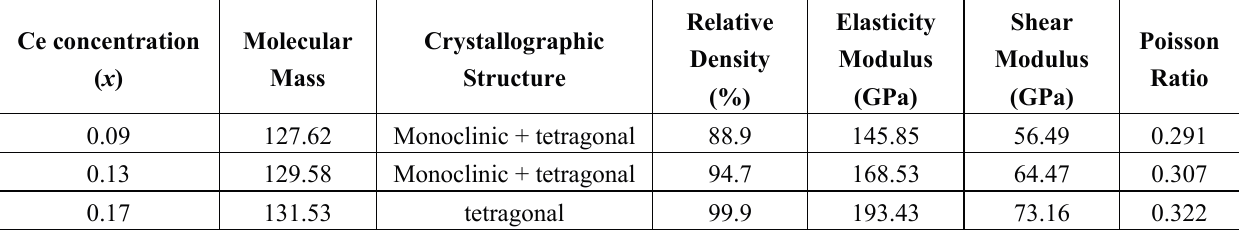
Table 5. Some crystallographic and mechanical characteristics of Zr 1- x Ce x O 2